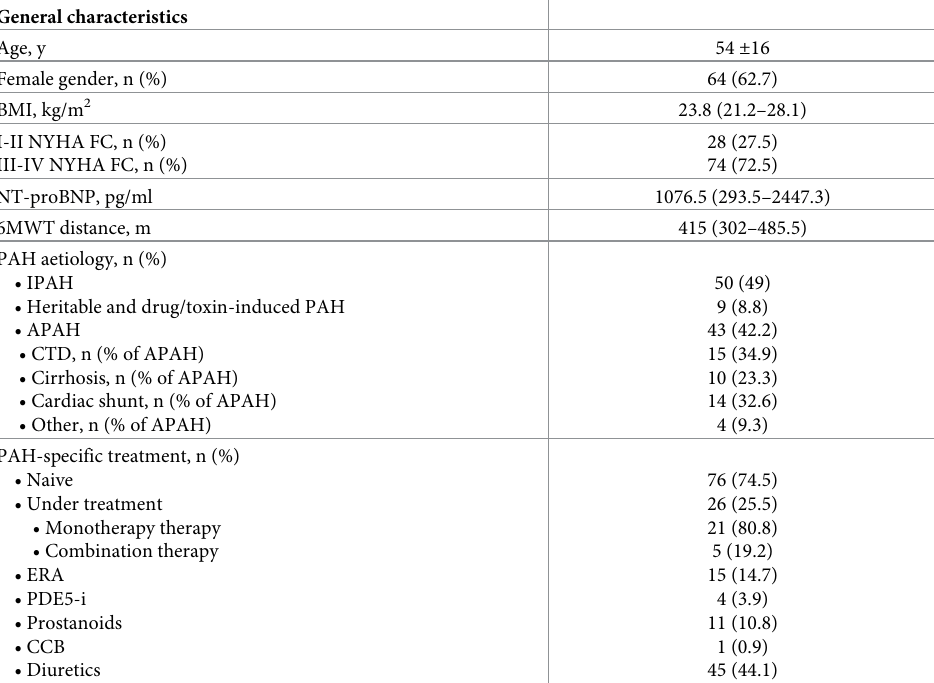
Table 1. General characteristics of the patients’ population (n 102). General